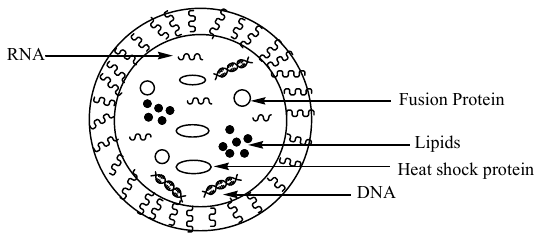
Figure 9. A schematic diagram of exosomes. Table 2. A summary of nanocarriers loaded with a combination of curcumin and selected anticancer drugs.